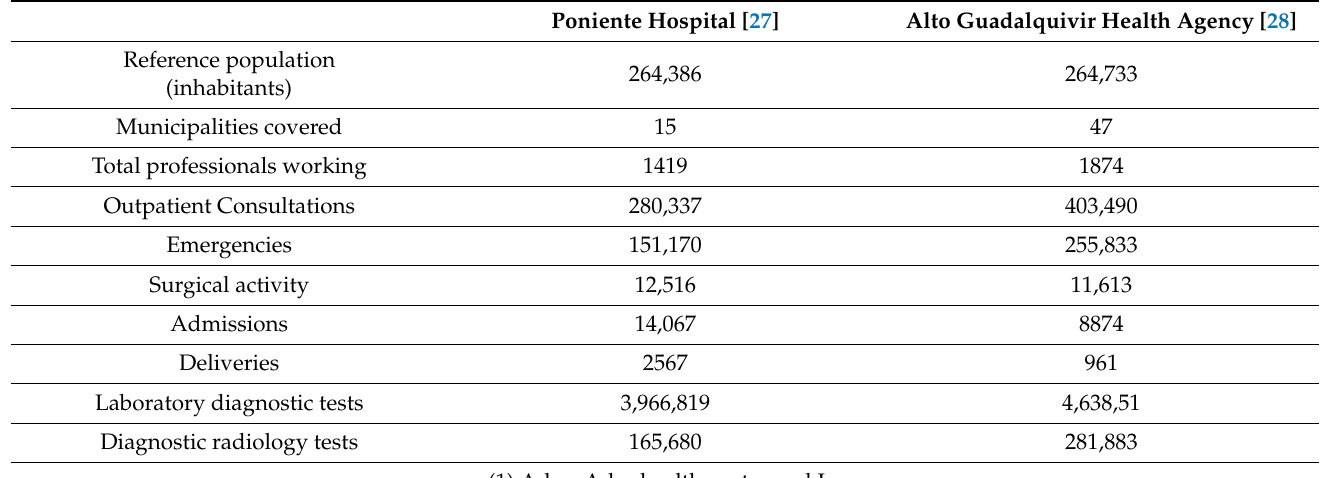
Table 1. Main characteristics of the healthcare institutions included in the